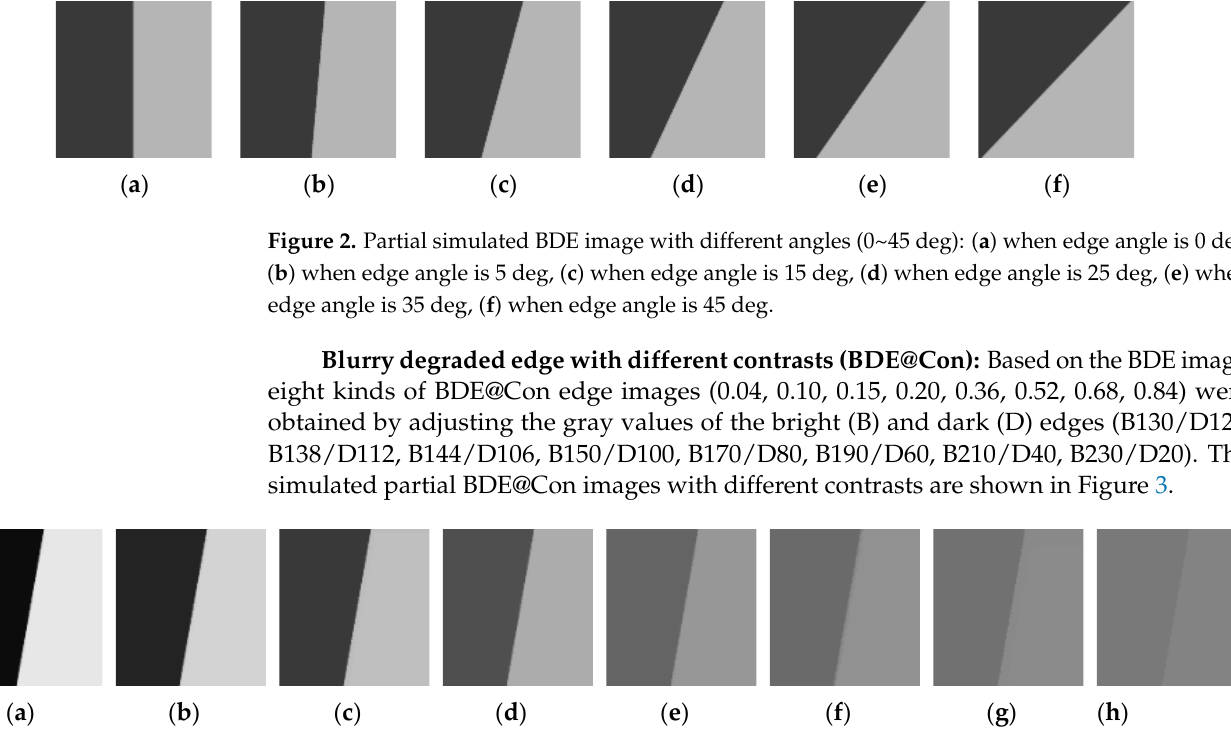
Figure 3. Partial simulated BDE@Con images with different contrasts when edge angle is 10 deg: ( a ) the contrast is 0.84, ( b ) the contrast is 0.68, ( c ) the contrast is 0.52, ( d ) the contrast is 0.36, ( e ) the contrast is 0.20, ( f ) the contrast is 0.15, ( g ) the contrast is 0.10, ( h ) the contrast is 0.04.